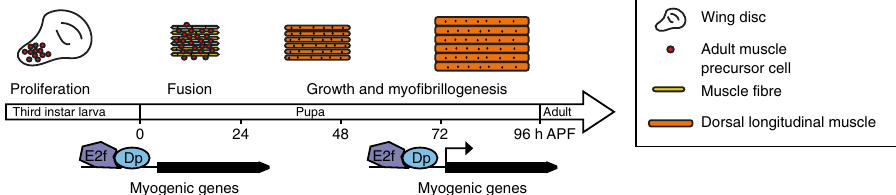
Figure 9 | Model of myogenic gene expression regulation by E2F/Dp during Drosophila development. The adult myoblasts are localized in the adepithelial layer of wing discs. The myoblasts proliferate through larval development and fuse to the nascent muscle fibres in the thoracic cavity of pupae. On completion of fusion ( B 36h APF), the developing DLMs significantly increase their size, and both sarcomere units and myofibrils are assembled. Although E2F/Dp complexes occupy promoters of myogenic genes throughout development, they are needed only within a narrow temporal window during muscle growth to directly control the expression of several muscle genes. This novel role for E2F in late muscle differentiation is necessary and sufficient for adult fly